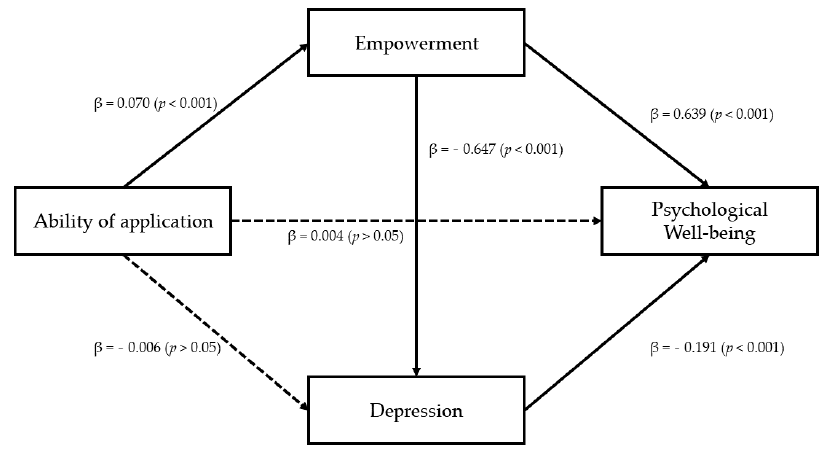
Figure 2. The result of verification of the double-mediating effect of empowerment and depression.